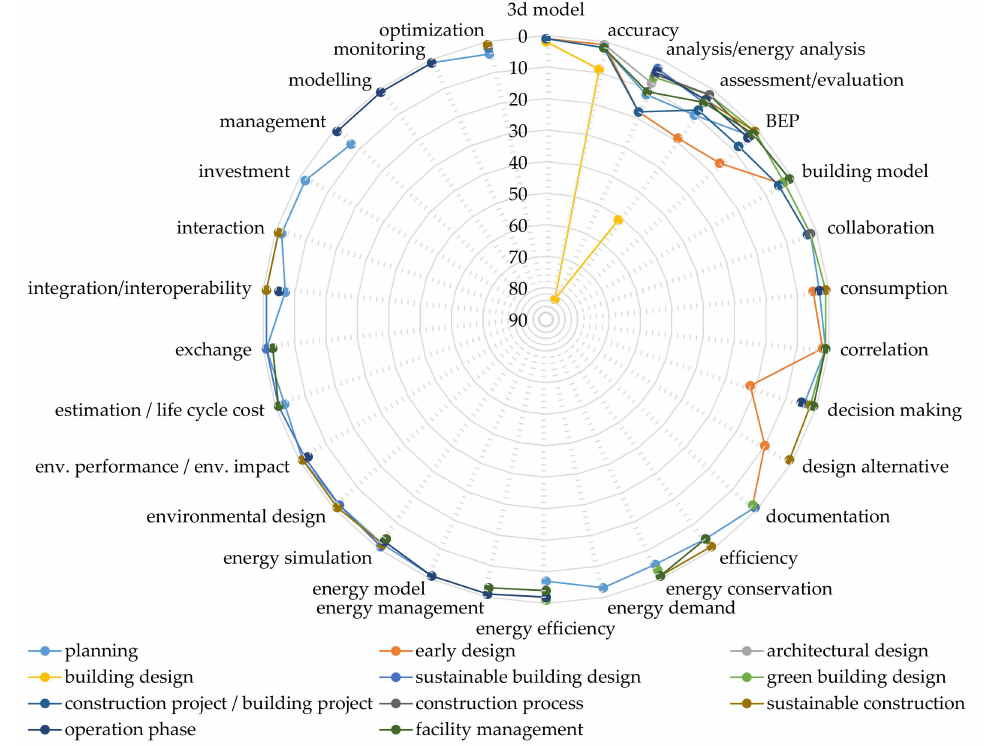
Figure 6. The stage–use case co-occurrence matrix in BIM and building energy efficiency analysis. Note: values of keywords co-occurrence are presented in reverse order to improve